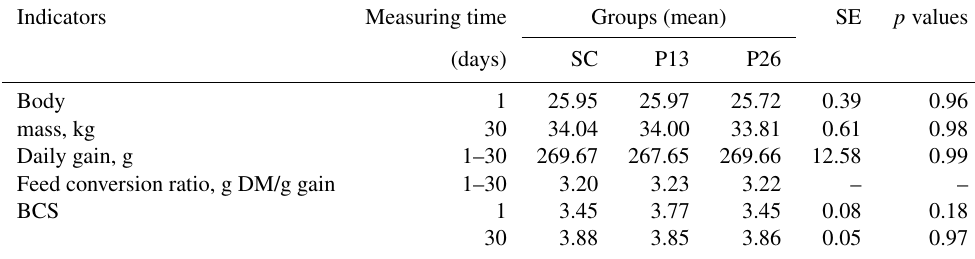
Table 3. Production traits of lambs. Indicators